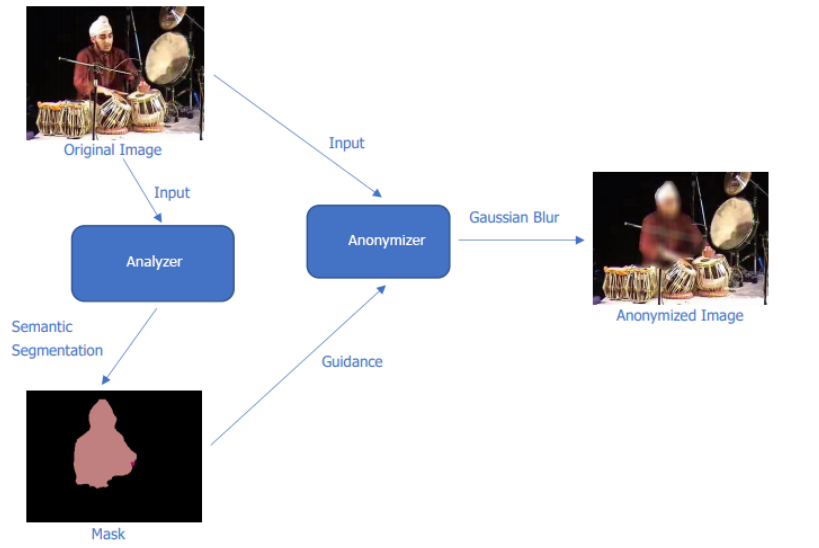
Figure 3. This system diagram shows the various processing stages of the algorithm. The raw image is fed into the semantic segmentor, which generates a pixel level label mask. These are both combined in the anonymization step to generate the final anonymized